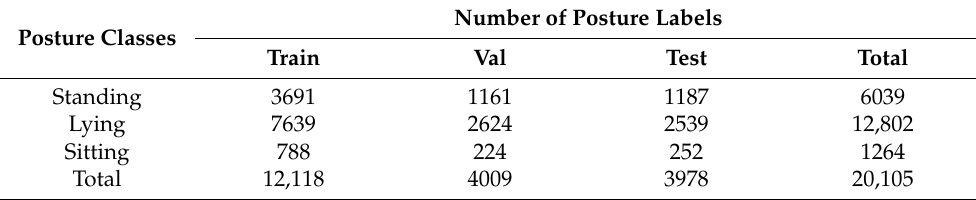
Table 2. Details of data annotation for pig